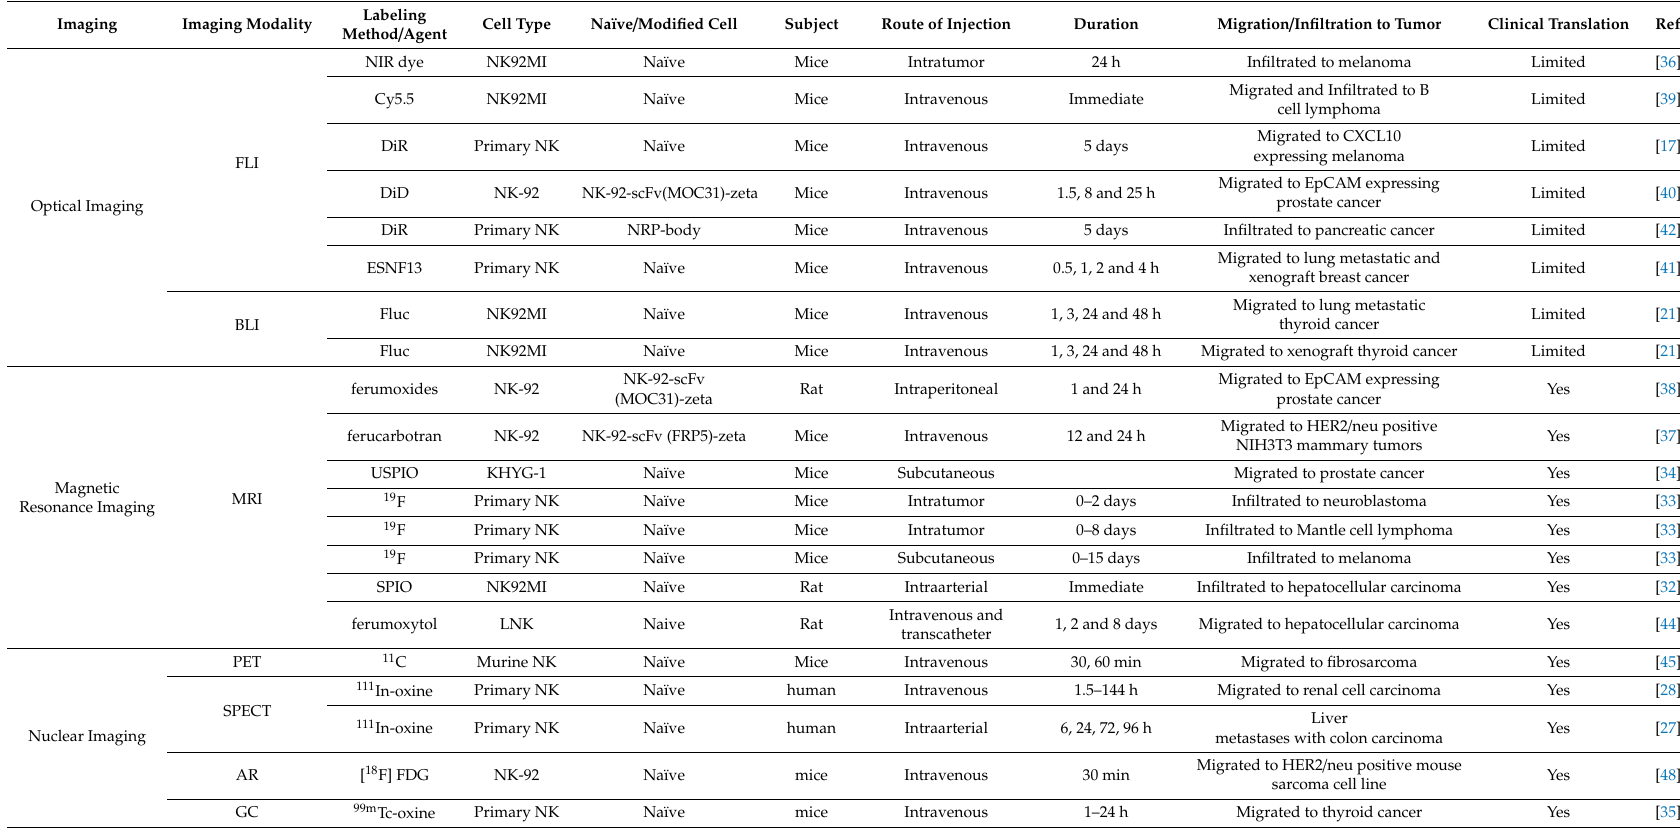
Table 1. In vivo monitoring of natural killer (NK) cell migration and infiltration into tumors by molecular imaging techniques.